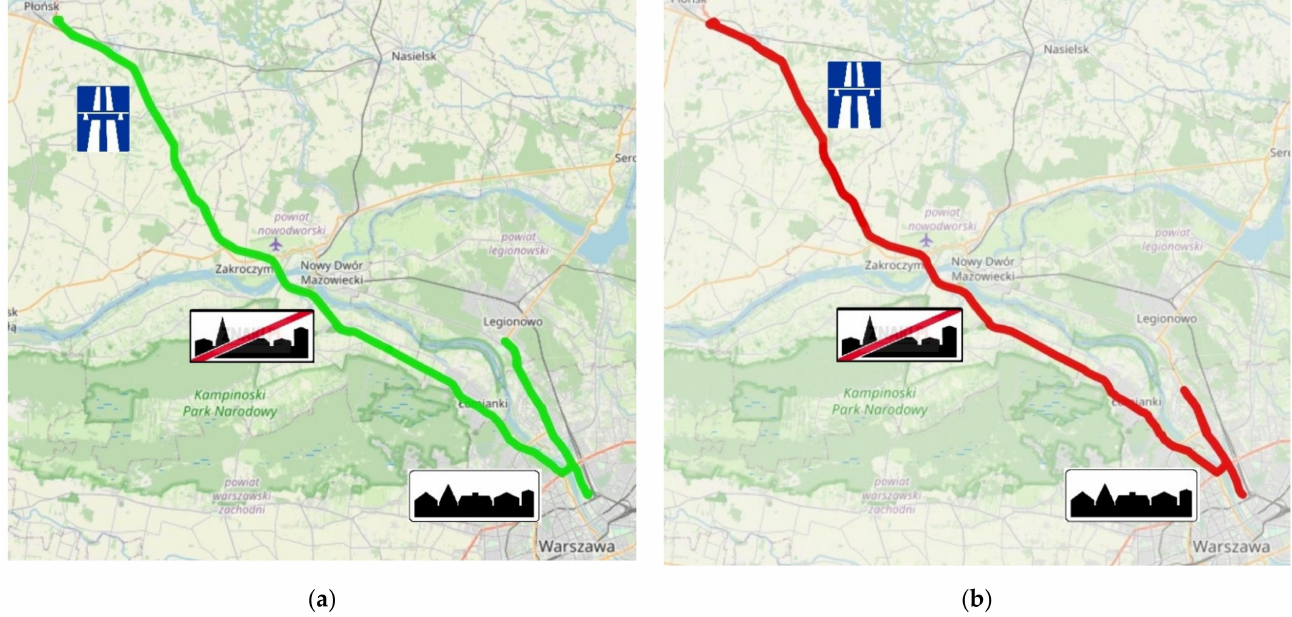
Figure 2. RDE trip route in tests of ( a ) N2 category vehicle; ( b ) N3 category